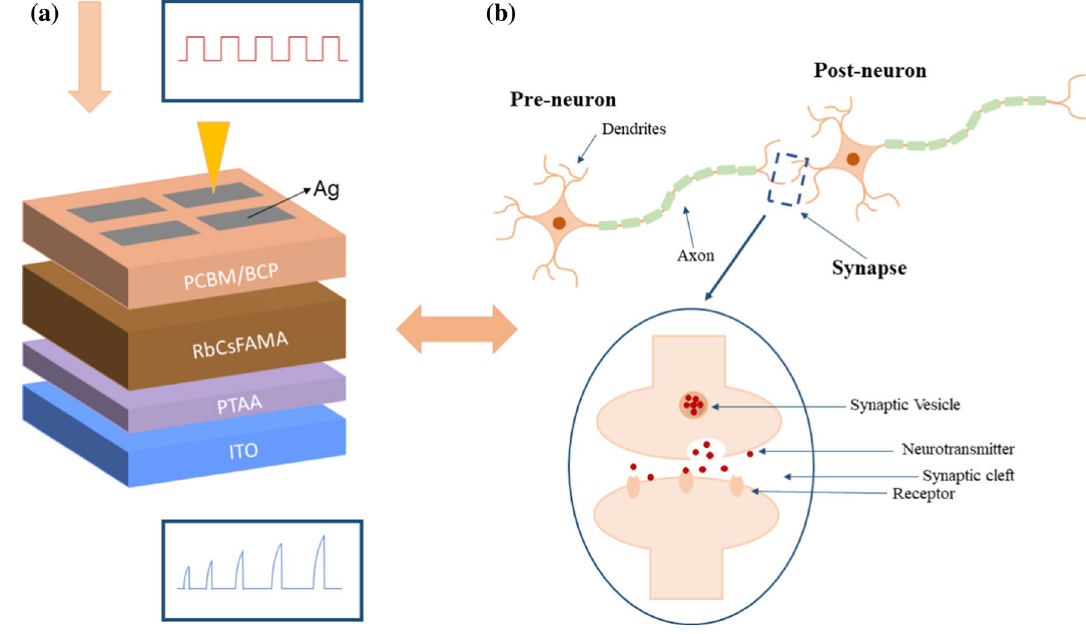
Fig. 1 ( a ) Schematic illustration of the perovskite synaptic memory device and ( b ). The biological synapse